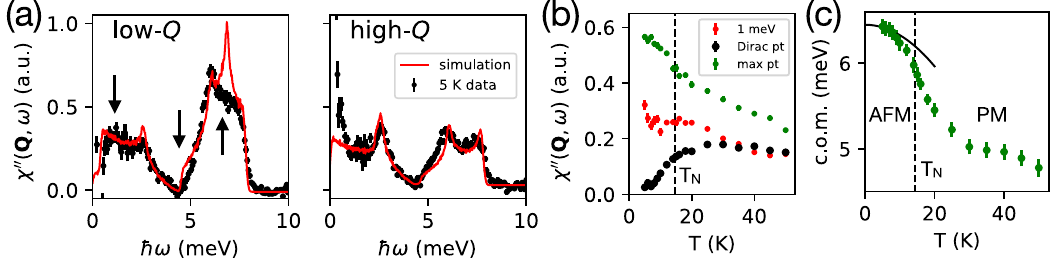
Fig. 4 Analysis of spin waves. a Comparison of 5 K inelastic data with calculated χ 00 Q ; ω ð Þ along low- and high- Q trajectories. The 5 K data has the 300 K data subtracted to eliminate the contribution from the 7 to 10 meV phonon feature, which can be seen in, e.g., the high- Q data in Fig. 3(h). Data are unsmoothed. b Intensities near 1 meV, the Dirac node energy, and the middle of the upper branch ( “ max pt ” ) for the low- Q trajectory. The Dirac node energies and the position and energy of the midpoint of the upper branch hump were determined by fi ts to a function of connected line segments. The intensities near the Dirac node and 1 meV were taken as an average within ±0.1 meV of these locations. c The center-of-mass (c.o.m.) position of the upper branch intensity plotted as a function of temperature. The black curve shows the expected fi rst-order renormalization (cid:1) h ω ¼ (cid:1) h ω 0 1 (cid:2) α 1 T 2 ð Þ of the honeycomb ferromagnet with nearest-neighbor interactions, where ffiffiffi p (cid:1) (cid:3) ¼ π = 24 α 35 . Error bars represent one standard deviation. 3 J 2 S 3 1